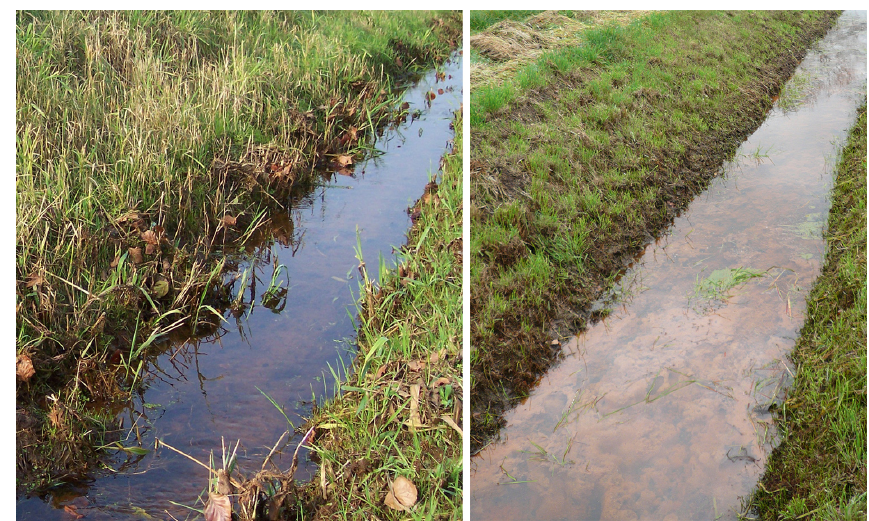
Figure 7. Pictures of the field ditch in the late summer (left panel) and winter (right panel). The red sediment indicates the presence of iron hydroxides in the winter situation. These were absent in